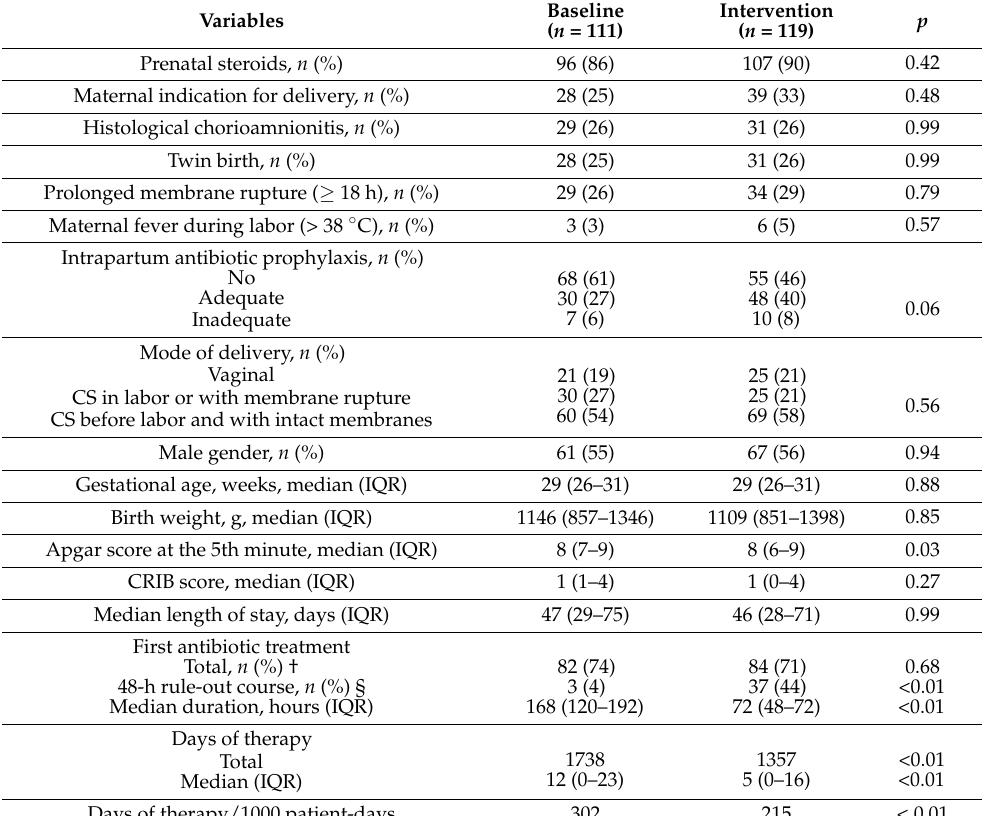
Table 1. Comparison of demographics, risk factors for early-onset sepsis, additional characteristics of very low birthweight (VLBW) neonates, and antibiotic use at baseline and in the intervention period.